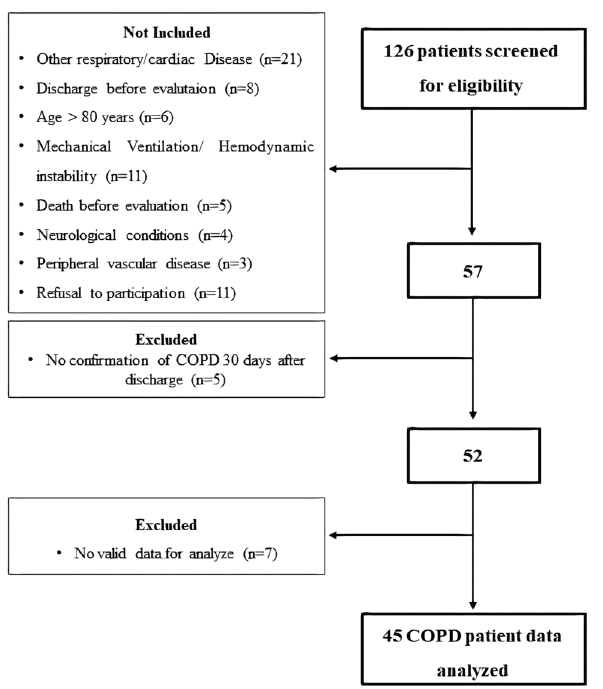
Figure 2. Study flow. COPD chronic obstructive pulmonary